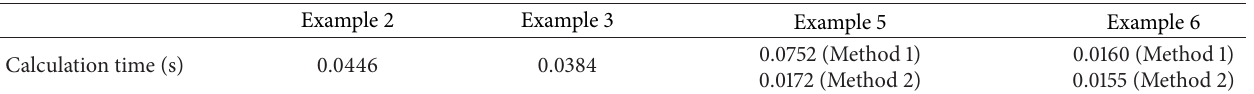
Figure 5: Comparison of expansion results of the proposed methods with reference (a) and relative errors of Method 1 (b) and Method 2 (c) in Example 6. Table 5: Calculation time of large-scale